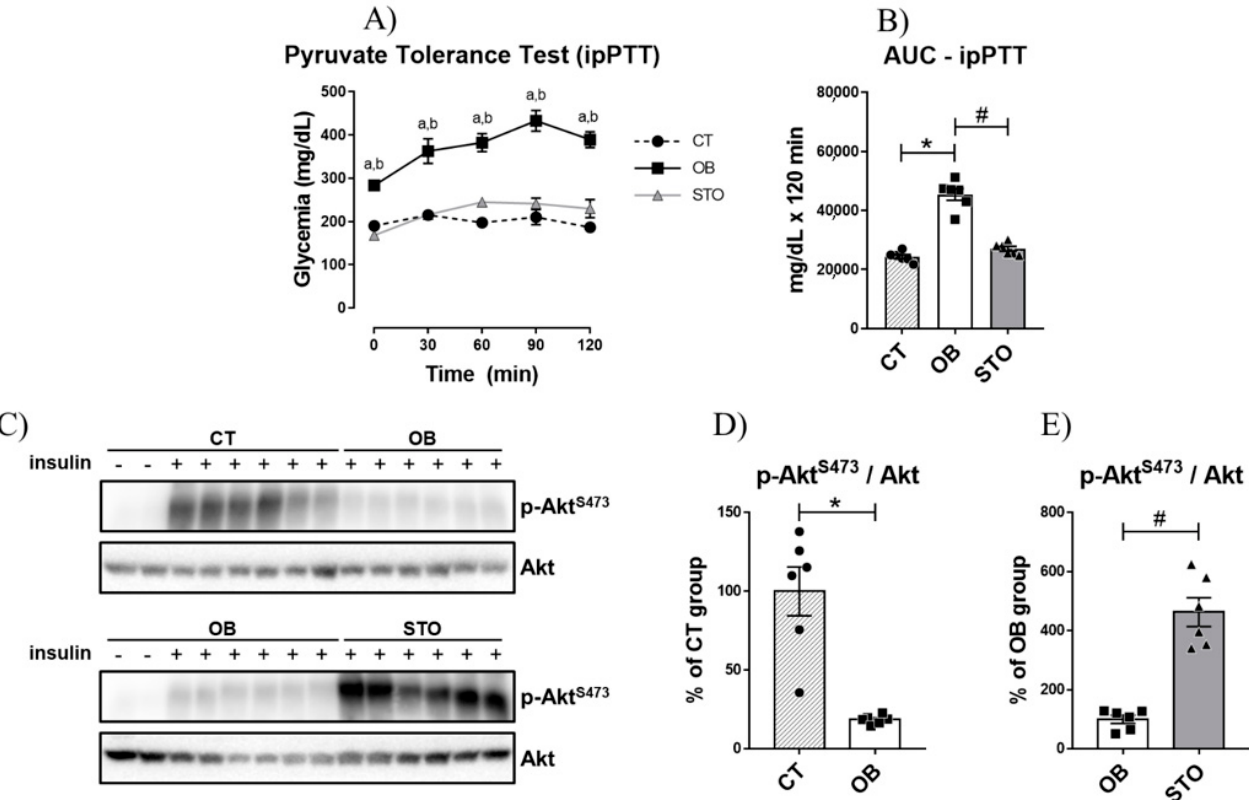
Figure 2. Hepatic Glucose Production and Hepatic Insulin Signaling. Glycemic curve during Intraperitoneal Pyruvate Tolerance Test (ipPTT) ( A ); Area Under the Curve (AUC) during ipPTT ( B ), Bands of phospho-Akt S473 and total Akt ( C ), Quantification of p-Akt S473 /Akt of CT and OB groups ( D ); Quantification of p-Akt S473 /Akt of OB and STO groups ( E ). n = 6 per group. CT = Control group; OB = Obese Sedentary Group and STO = Strength Training Obese. In ( A ): a = p < 0.05 for CT vs. OB; b = p < 0.05 for OB vs. STO. In ( B , D , E ): * p < 0.05 vs. CT; # p < 0.05 vs. OB. CT: n = 8 (2 saline injection + 6 insulin injection)—OB: n = 8 (2 saline injection + 6 insulin injection)—STO n = 6 (all insulin injection). The statistical analysis was performed with insulin injected mice.